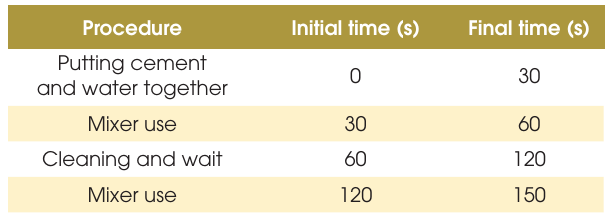
Table 2 – Process of mixing materials